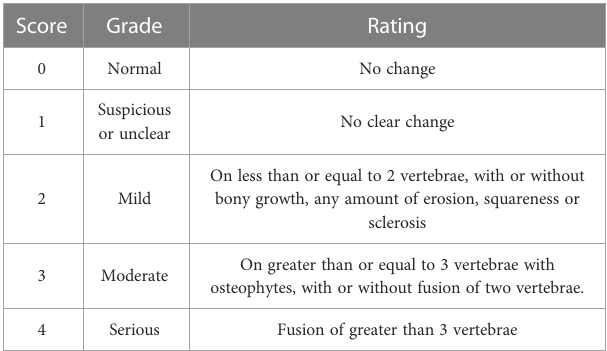
TABLE 1 BASRI grade classi fi cation and scoring